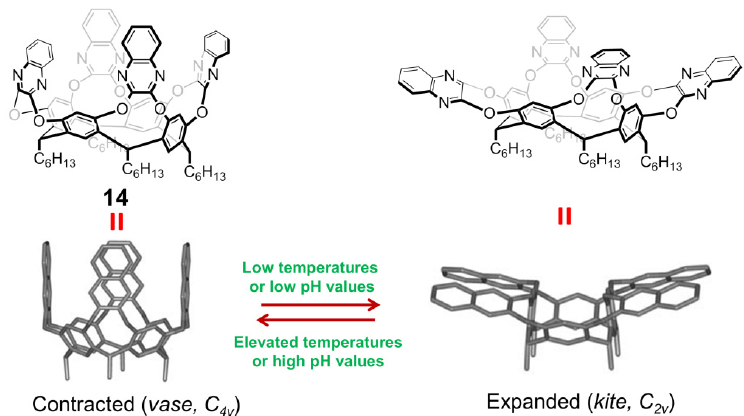
Copyright 2006 John Wiley and